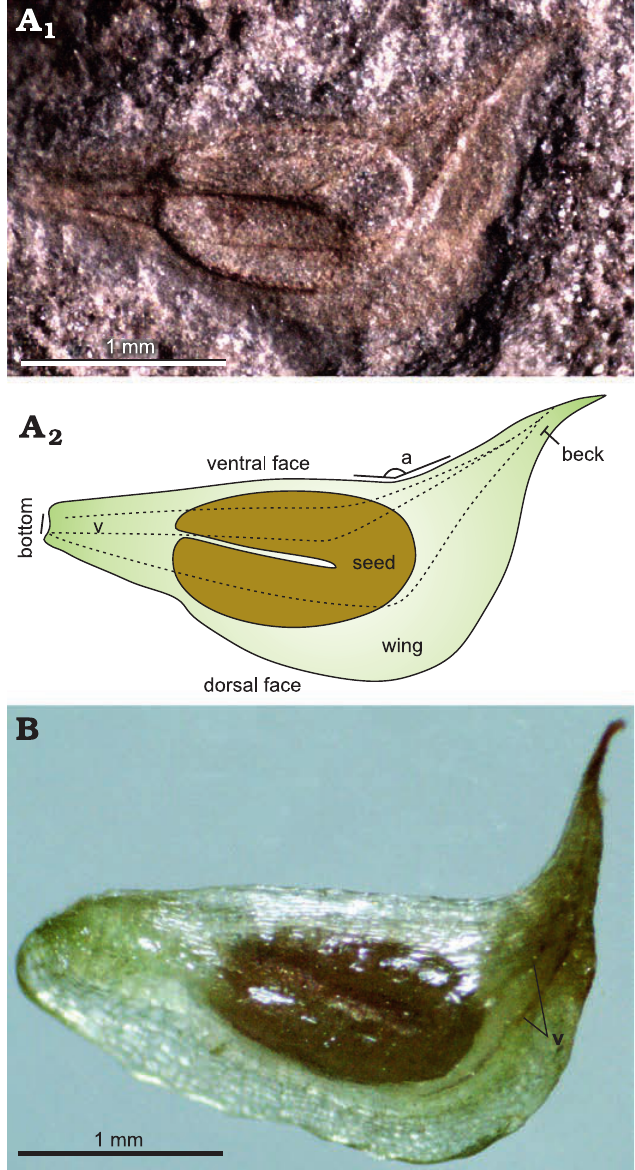
Fig. 3. Fossil and extant fruits of alismataceous plant Sagittaria montevi- densis Chamisso and Schlectendal, 1827. A . CTES-PB 12911, Quebrada El Estanque (Palo Pintado Formation), upper Miocene, fossil fruit (A 1 ), explan- atory drawing (A 2 ), dotted lines (v) represent veins present in the fossil fruit (a, angle formed by the beak and the ventral face); B . Recent fruit where the veins (v) are present, but with a slight development. The Recent material is deposited in the CTES herbarium (Corrientes City), as Sagittaria montevi- densis Chamisso and Schlectendal, 1827 subsp. montevidensis